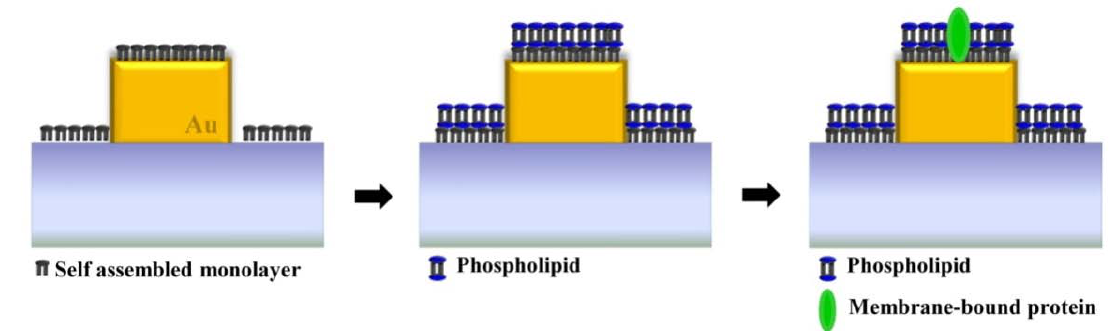
Figure 13. Detection of supported lipid membrane and membrane-bound protein at the gold nanostructure through LSPR peak